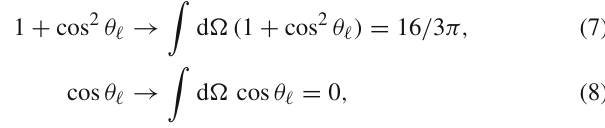
tions. In the following the G μ scheme is used, in which G F , m W , m Z are set to G F = 1 . 1663787 · 10 − 5 GeV − 2 , m W = 80 . 385 GeV, m Z = 91 . 1876 GeV, and sin 2 θ